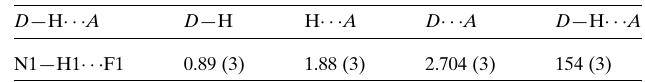
Table 2 Hydrogen-bond geometry (A˚ , (cid:5) ).